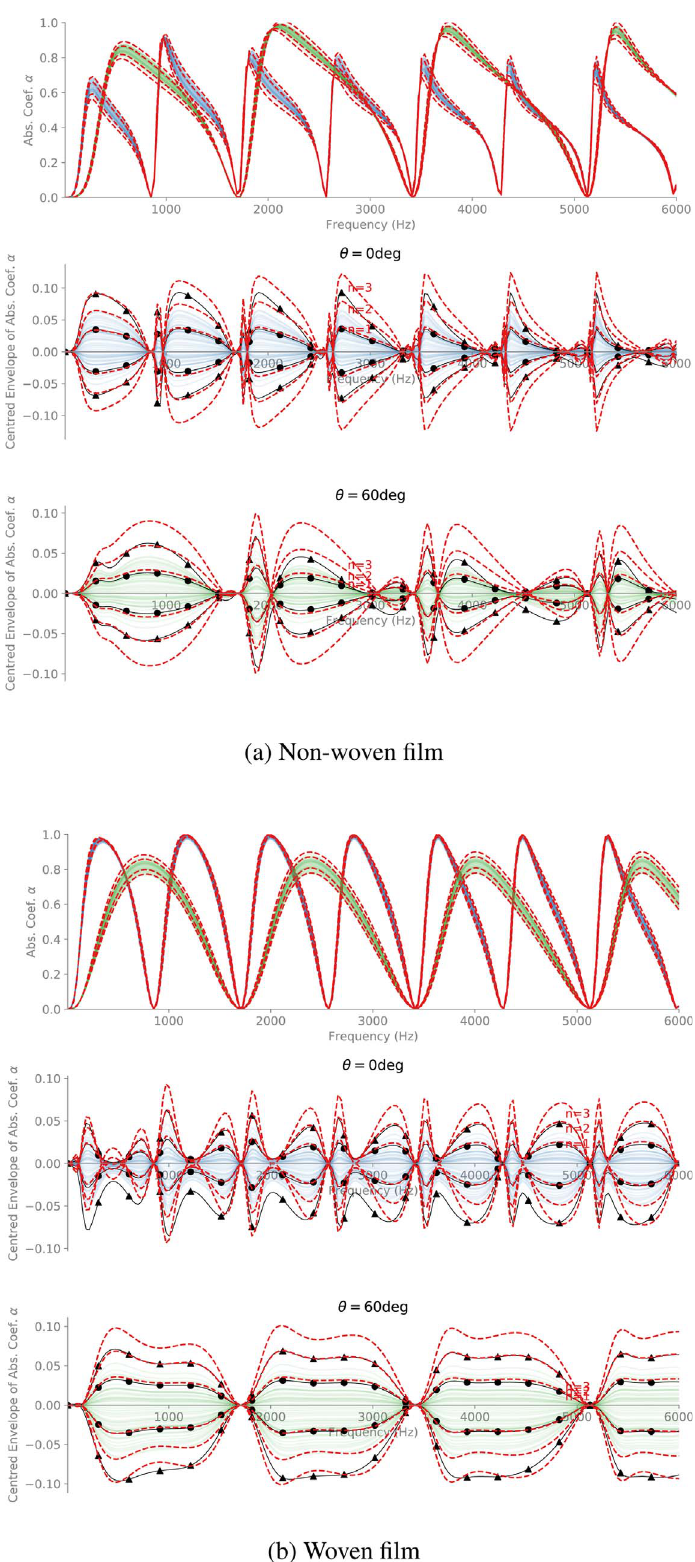
Figure 5. Case of a varying thin fi lm upstream a 200 mm air plenum. Quantities and line styles identical to Figure